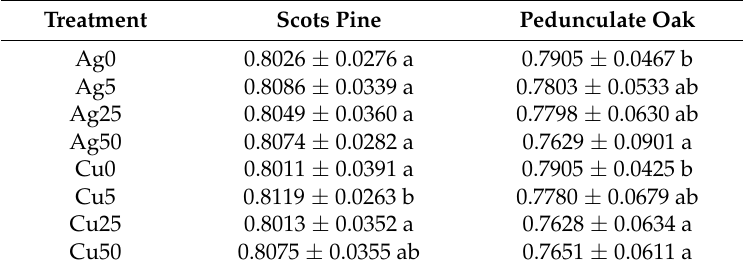
Table 2. Maximum efficiency of photosystem II (F v /F m ), mean ± SE, among one-year-old Scots pine and pedunculate oak seedlings dosed with different concentrations of AgNPs and CuNPs.